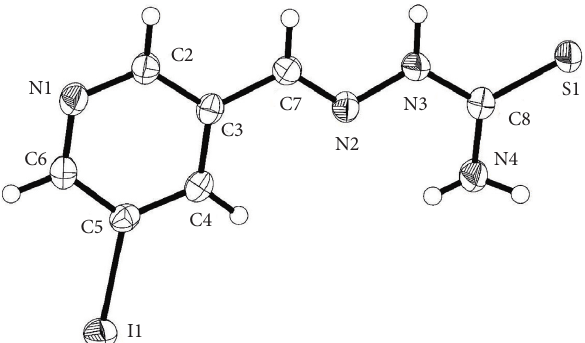
Figure 4: ORTEP diagram of 7 with thermal ellipsoids at the 50% probability level.